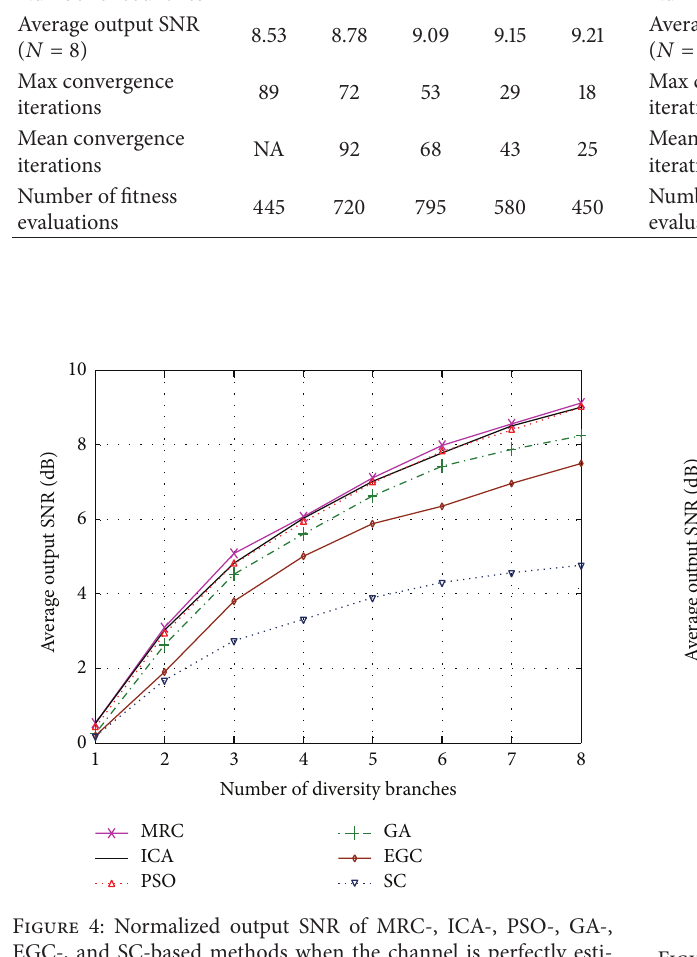
Figure 5: Comparison of normalized output SNR of ICA-, PSO-, GA-, MRC-, EGC-, and SC-based methods for imperfect channel